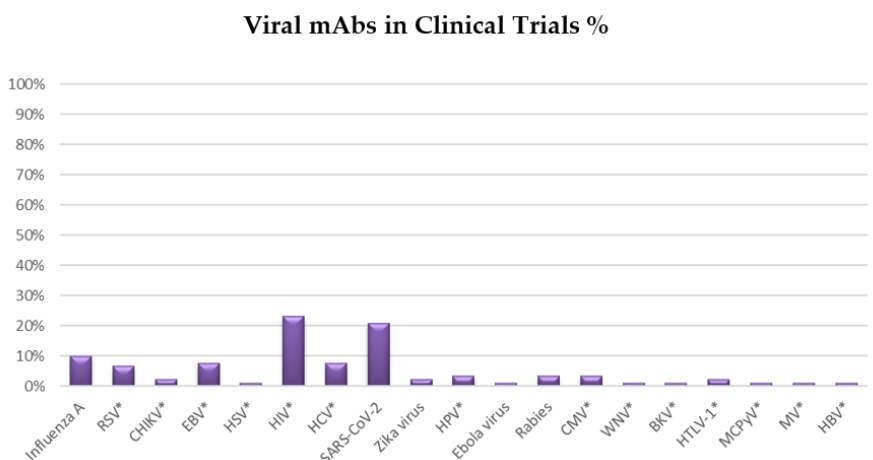
Figure 2. Pie chart summarizing the distribution of clinical trials for mAbs against viral diseases.